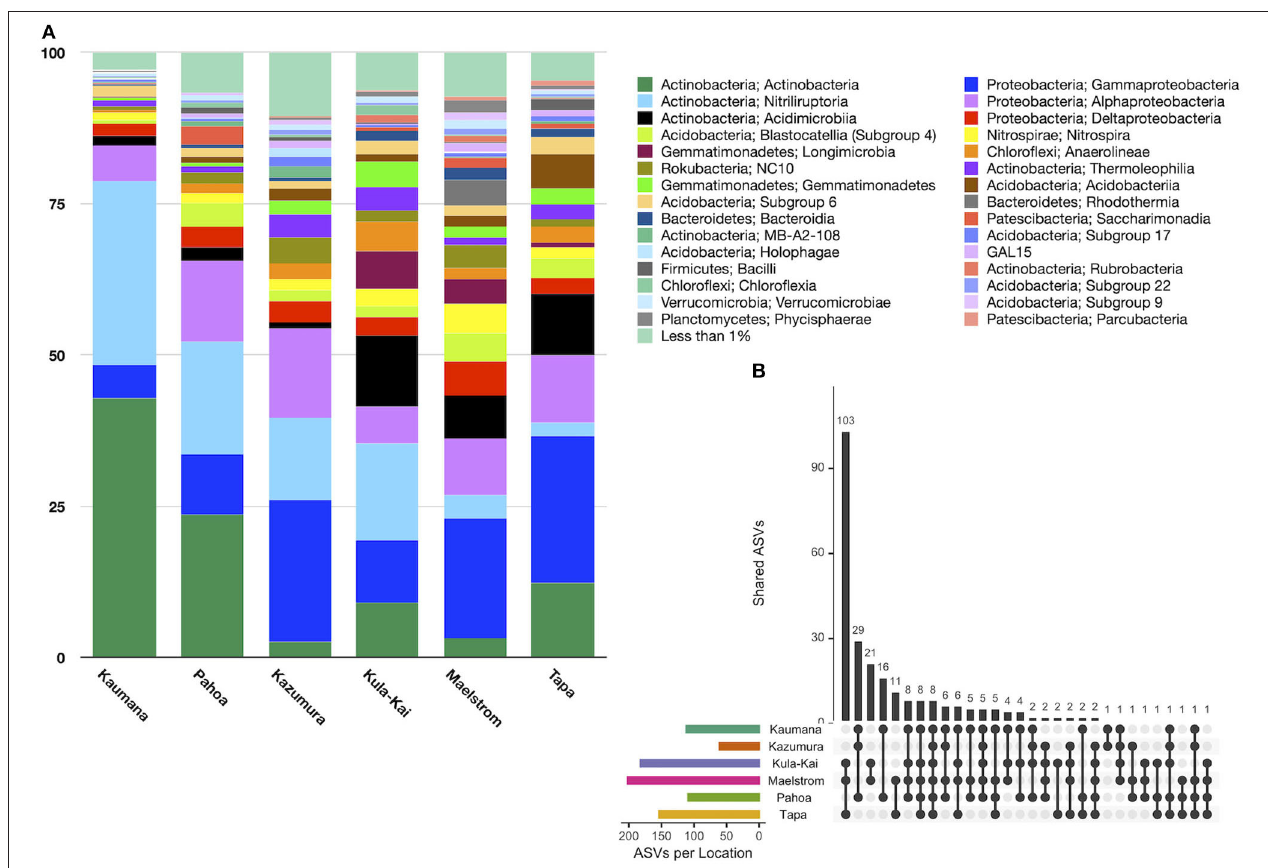
FIGURE 4 | (A) Relative abundance by the site of class-level taxa with > 1% abundance in lava tubes. Dominant taxa in these features were Actinobacteria (16.0% ± 24.4), Gammaproteobacteria (15.4% ± 11.0), Nitriliruptoria (13.7% ± 23.3), and Alphaproteobacteria (9.8% ± 10.7). Longimicrobia and Acidimicrobiia ASVs were considerably more abundant in the Kipuka Kanohina cave system in the south of the island of Hawai‘i. (B) Upset plot of lava tube sites shows that individual lava tubes are moderately unique, with Maelstrom cave hosting 1,277 unique ASVs, followed by Kaumana cave (1,022 unique ASVs). Only seven ASVs occurred in all lava